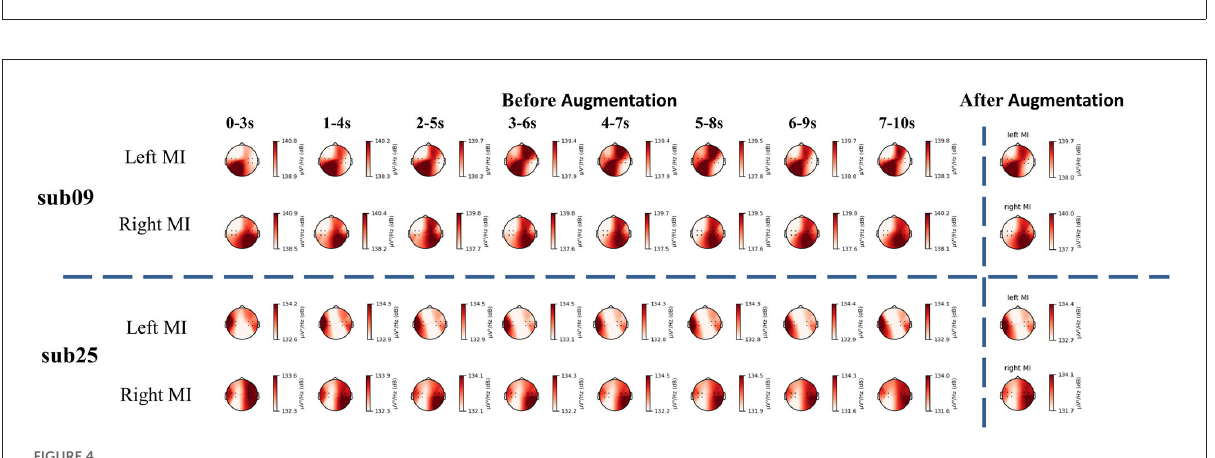
FIGURE4 The PSD analysis of EEG signal. The PSD analysis of sub09 is shown above the horizontal dashed line and that of sub25 is shown below the horizontal dashed